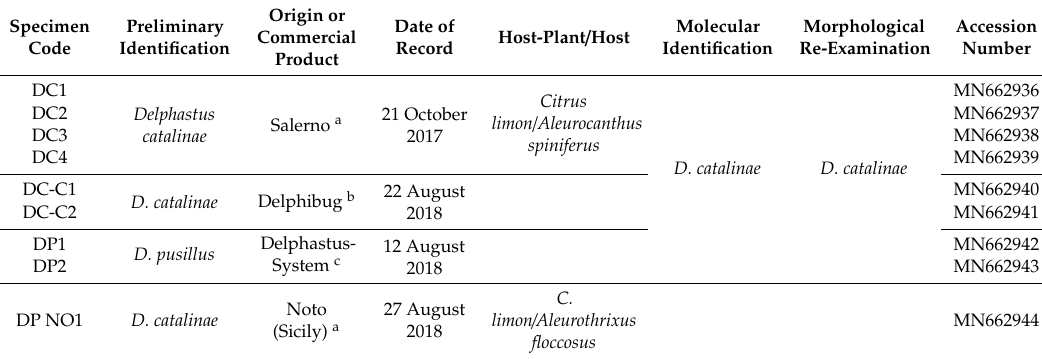
Table 2. Beetle specimens used in this